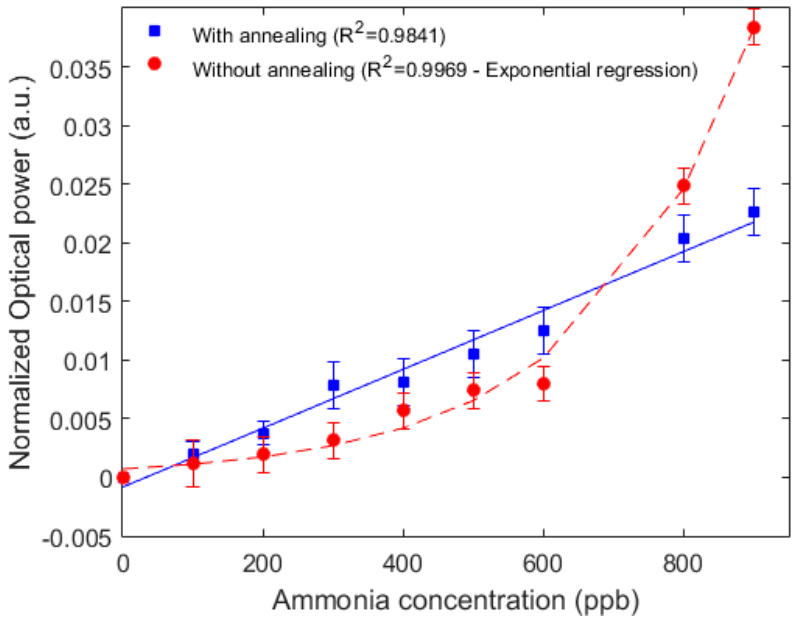
Figure 5. Comparison between the fiberoptic probe responses with and without annealing as a function of the ammonia